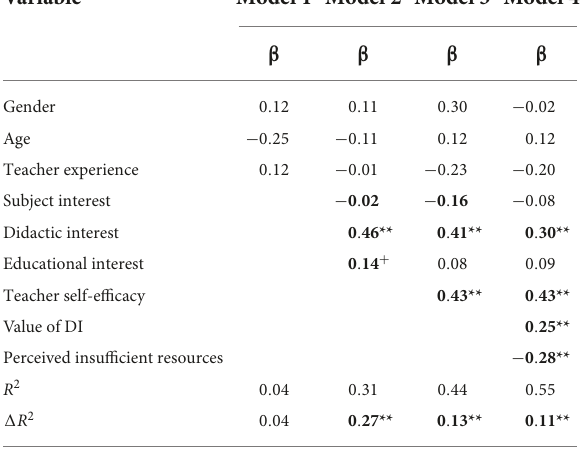
TABLE 2 Multiple regression models: prediction of teachers’ implementation of instructional adaptations. Variable